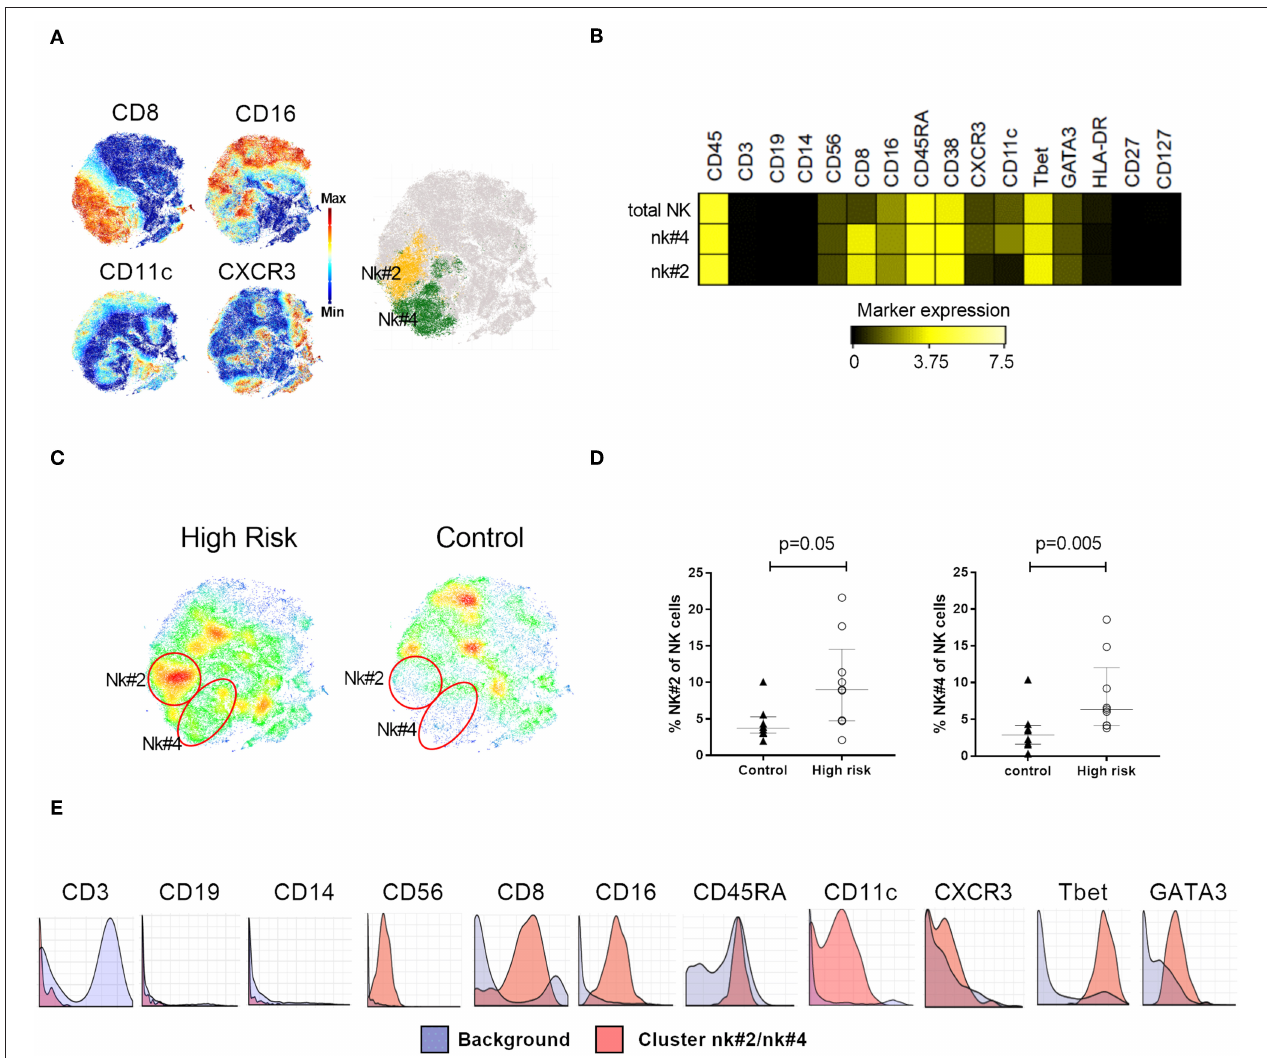
FIGURE 4 | NK cell phenotyping. (A) Clustering analysis on NK cells expressing CD8, CD16, CD11c, and CXCR3 characterized two NK subsets, nk#2 (yellow) and nk#4 (green), highlighted on the t-SNE map (B) Median expression of relevant markers used for the identification of NK subsets nk#2 and t4#4. (C) t-SNE plots illustrating cellular density in individuals with high risk for type 1 diabetes and controls. (D) Percentage of nk#4 and nk#2 subsets within total NK cells in high-risk individuals ( n = 9, white circles) and controls ( n = 9, black triangles). (E) Citrus-generated histograms showing marker distribution in cluster nk#2/nk#4 (red) in relation to background expression (blue). Background was determined by all the cells that don not belong to the clusters significantly different between the groups, i.e., whole PBMC. Dots represent individual samples. Error bars show median ± interquartile range. Median expression values were transformed using arcsinh function in a cofactor of 5. p -values for differences between groups were determined using Mann-Whitney U-test. p < 0.05 was considered